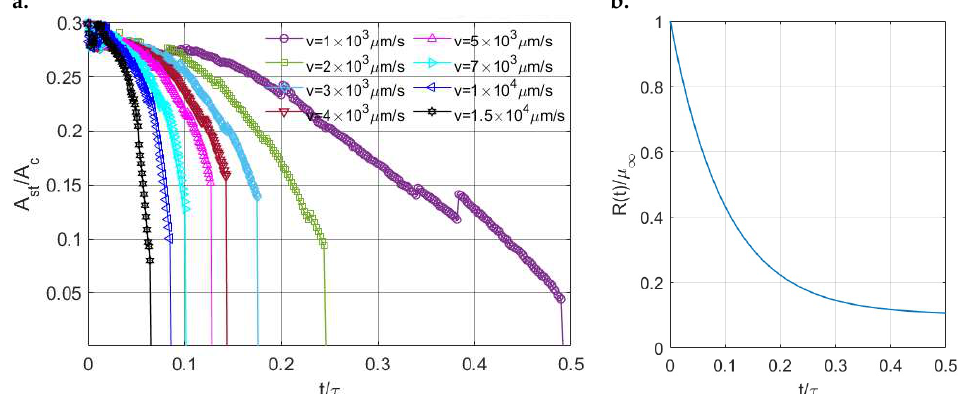
Figure 25. ( a ) Fully coupled solution regarding the variations in the stick ratio with time under different increasing rates of displacement and ( b ) Variations in relaxation modulus R ( t ) of the material with